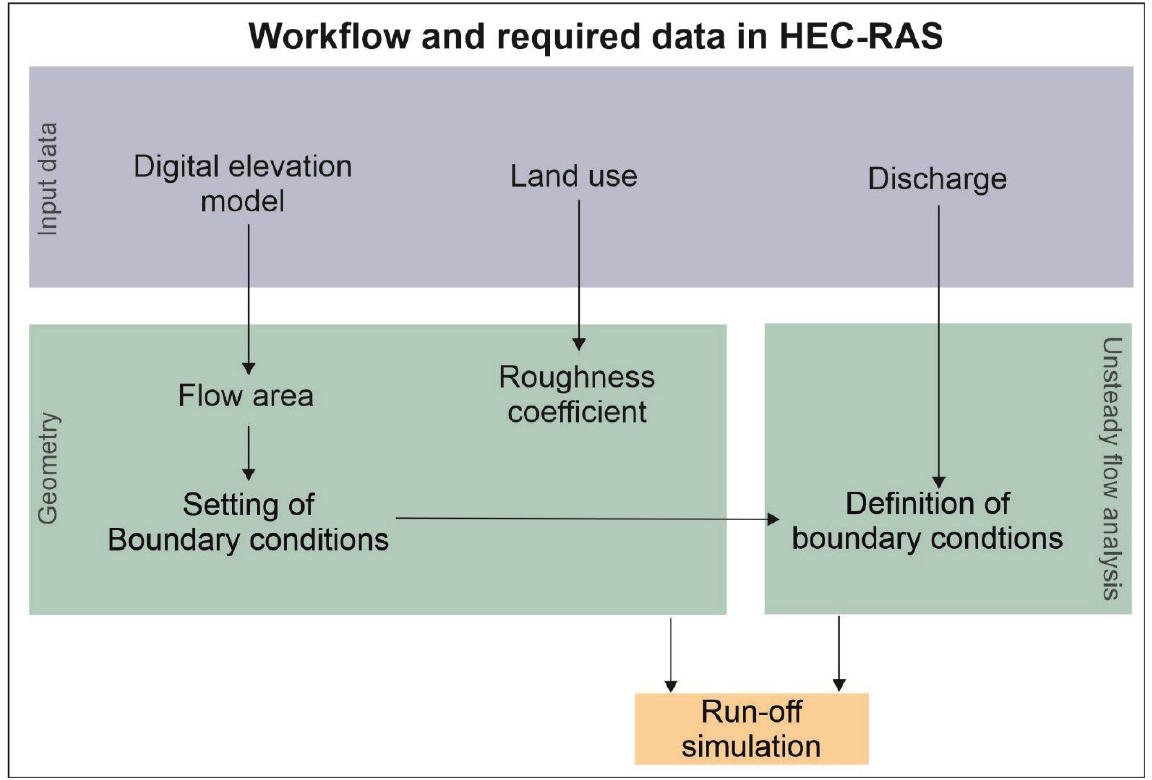
Figure 2. Schematic representation of the workflow in